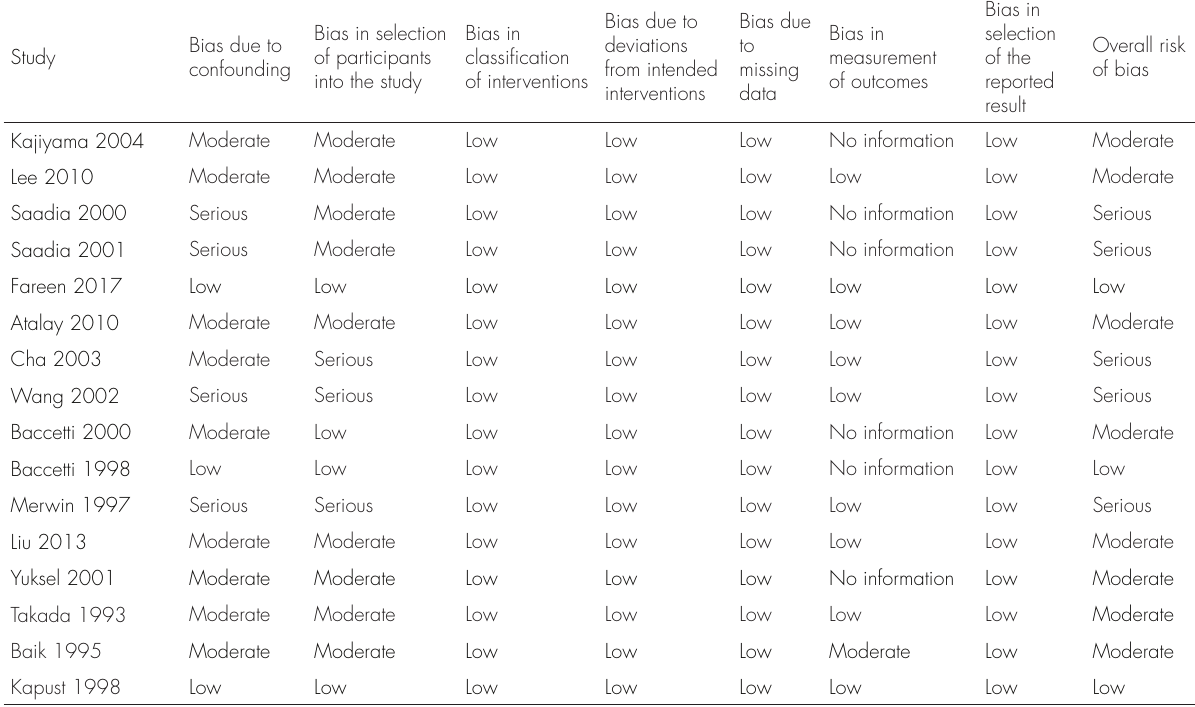
Table III. Risk of bias of the included studies assessed by ROBINS-I (Risk Of Bias In Non-randomized Studies of Interventions).